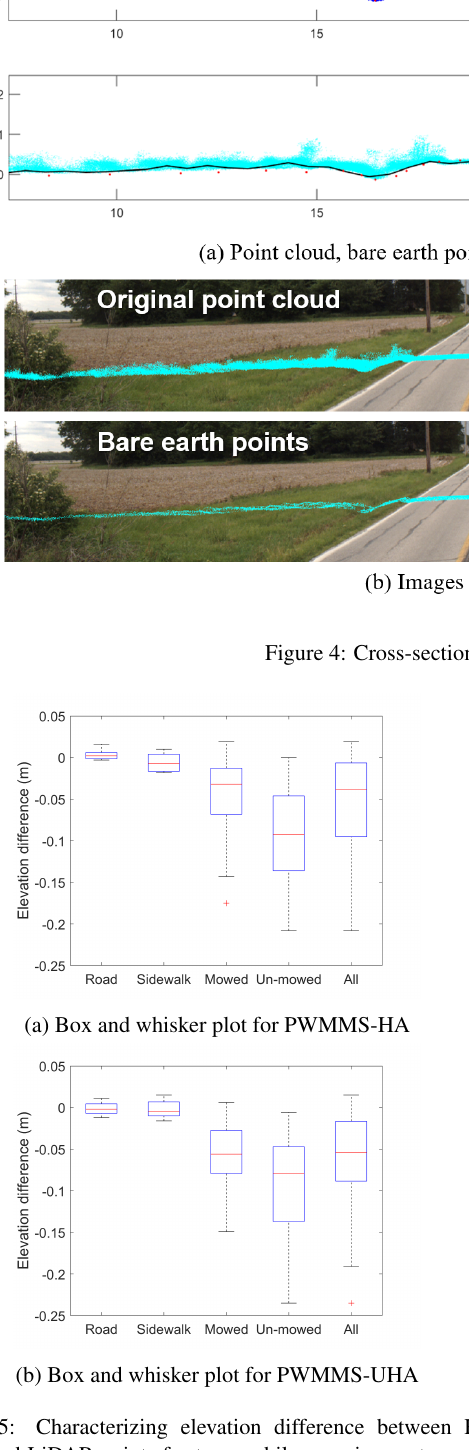
Figure 5: Characterizing elevation difference between RTK points and LiDAR points for two mobile mapping systems with residual plots of range, 25 th percentile, median, and 75 th per- centile.